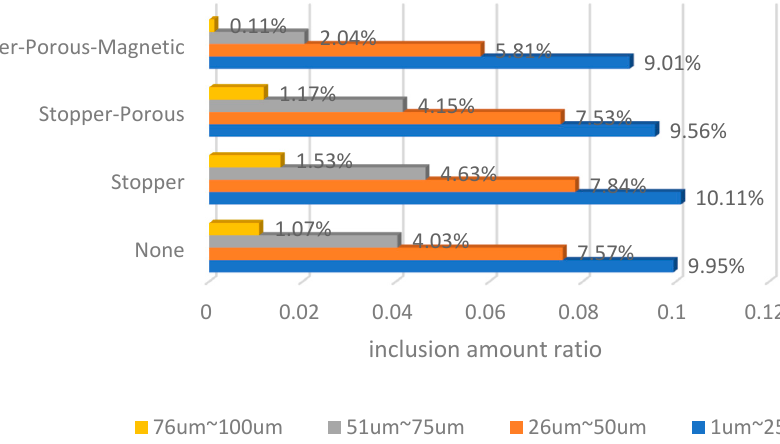
Figure 7. Statistical analysis of the ratio of inclusions particles outflow from the slit nozzle.